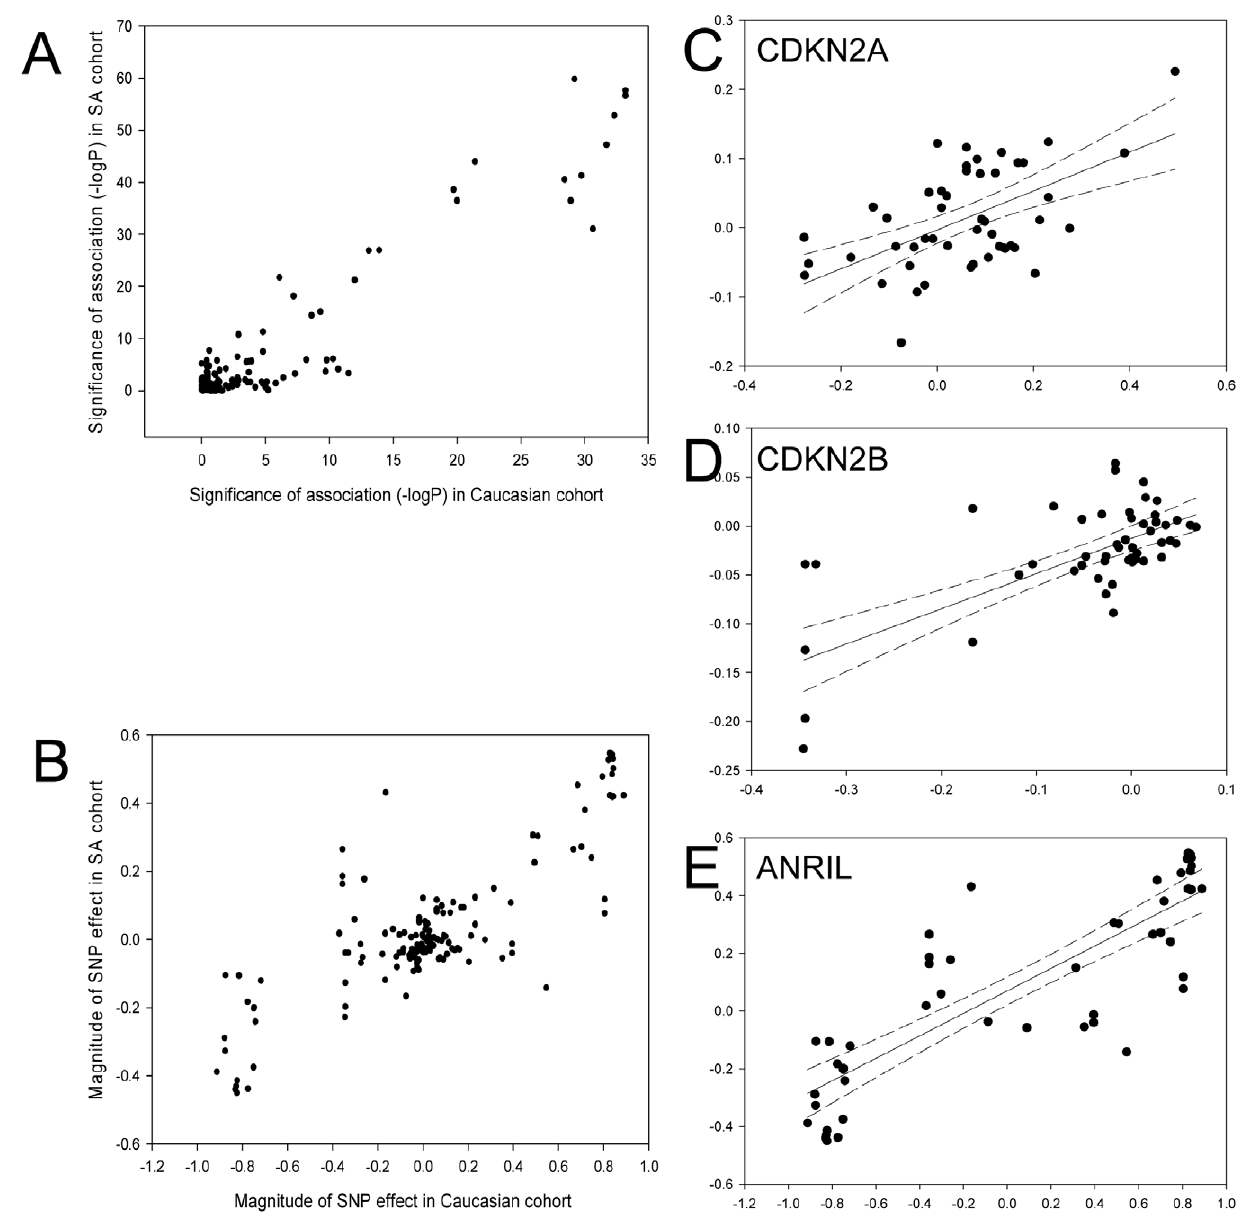
Figure 3. SNP effects in the SA and Caucasian cohorts. Scatter plots show the correlation between aeQTL results obtained in the SA (Y-axis) and Caucasian cohorts (X-axis) for: (A) significance of association with expression ( 2 log P value) for all three genes; (B) effect size at each SNP for all three genes; (C) effect size at each SNP for CDKN2A only; (D) effect size at each SNP for CDKN2B only; (E) effect size at each SNP for ANRIL only. Linear regression line for the association is shown as a solid line with the 95% confidence intervals shown as dotted